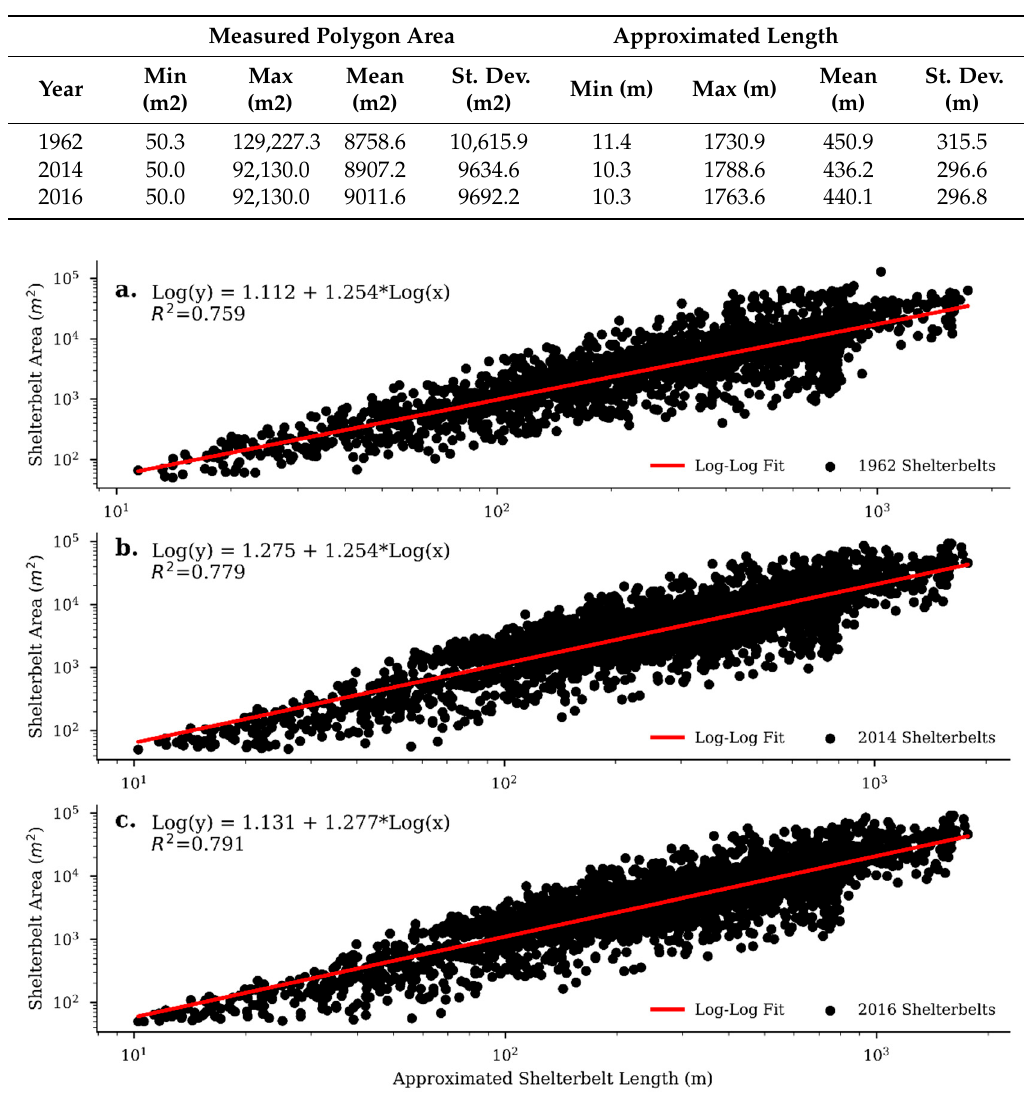
Figure A1. A regression analysis assessing the relationship between shelterbelt length and area. The two are highly correlated ( p < 0.0001) across all three years: ( a ) 1962, ( b ) 2014, and ( c ) 2016, which allows area to serve as a proxy for shelterbelt length.